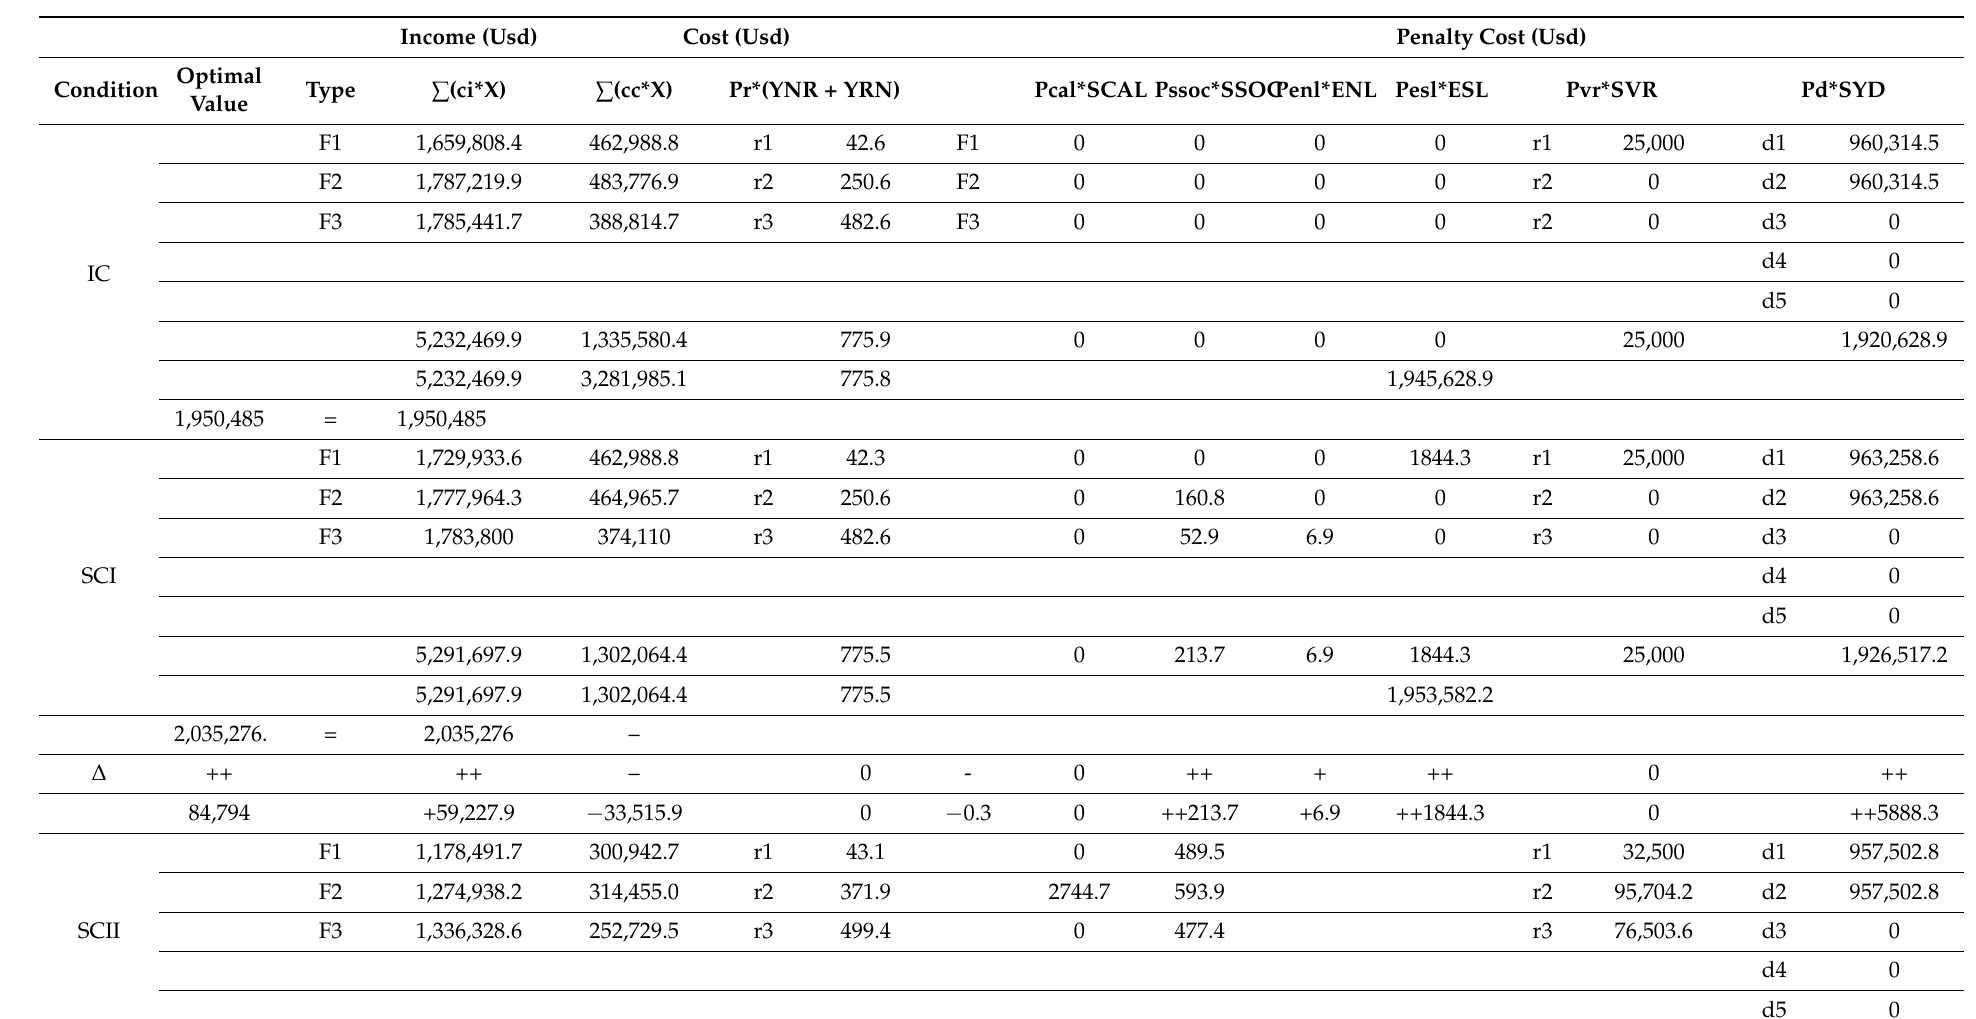
Table 12. Comparison of objective functions values under the initial, scenario I, and scenario II